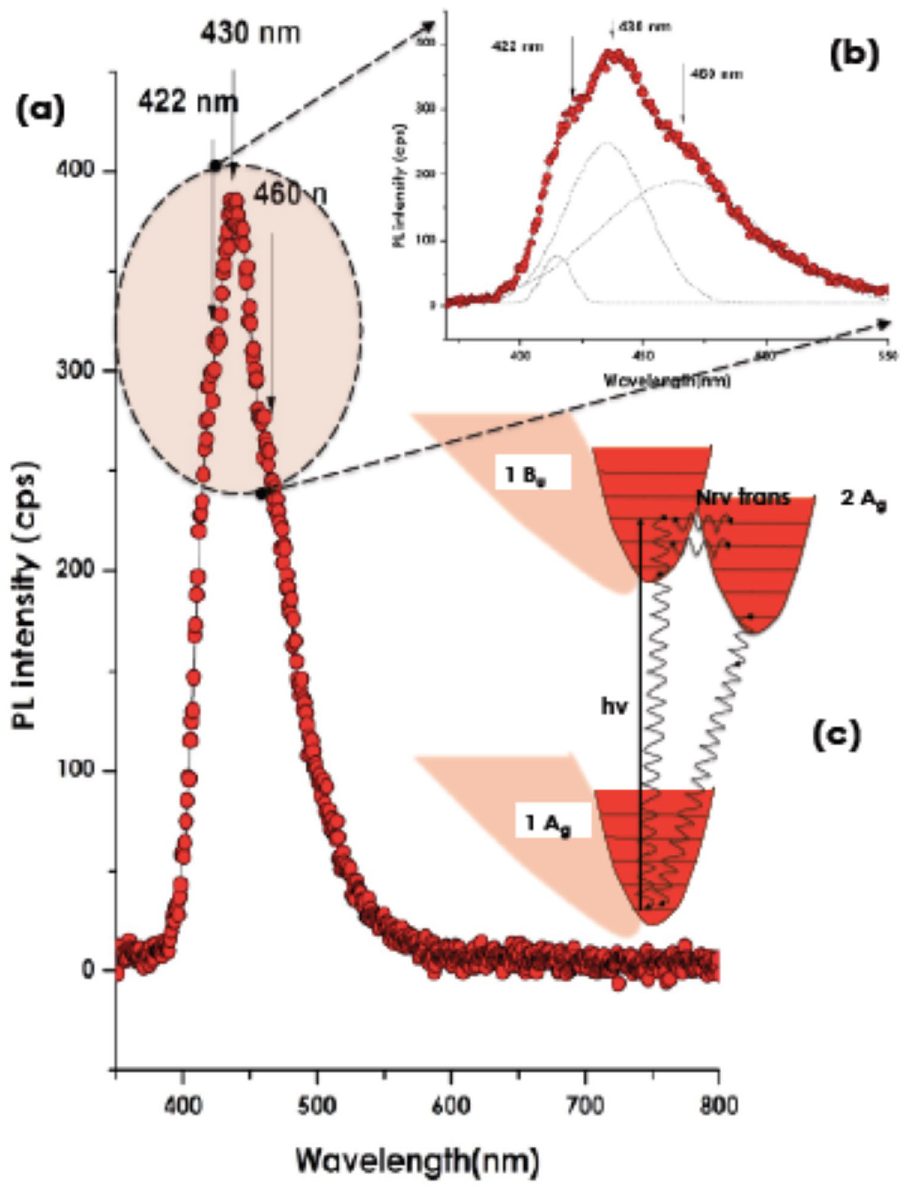
Figure 4. ( a ) Fluorescence emission of lycopene, ( b ) Zoom on the major Emission peaks and their convolution, ( c ) Schematic energy level diagram for carotenoids. Here 1A g , is the ground state and 1B u , the allowed excited state. 2A g , is a forbidden excited electronic state populated by non-radiative relaxation from the 1B u